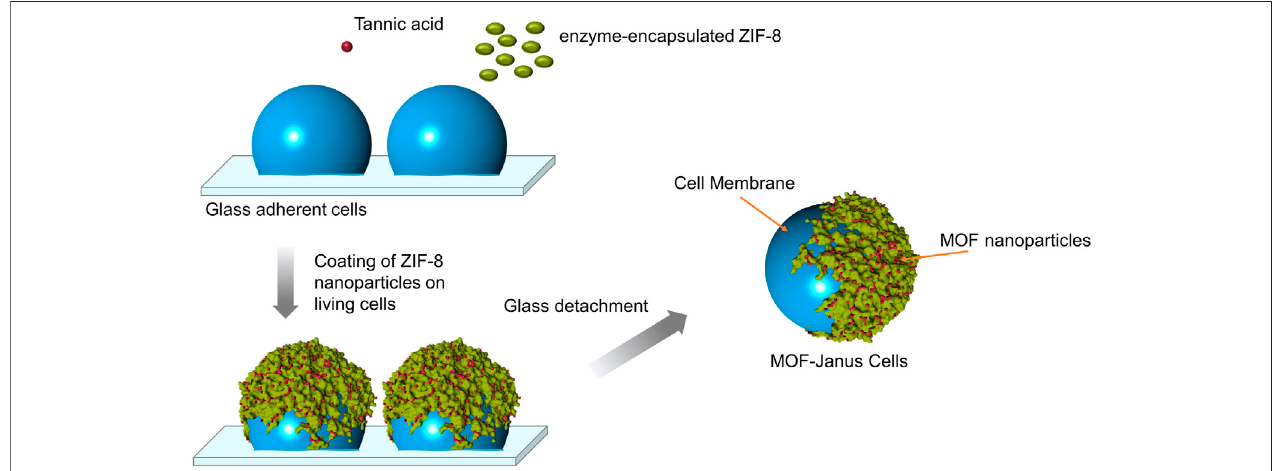
FIGURE 8 | Schematic Illustration of the development of MOF-Janus cell-based drug delivery system (Ha et al., 2021).